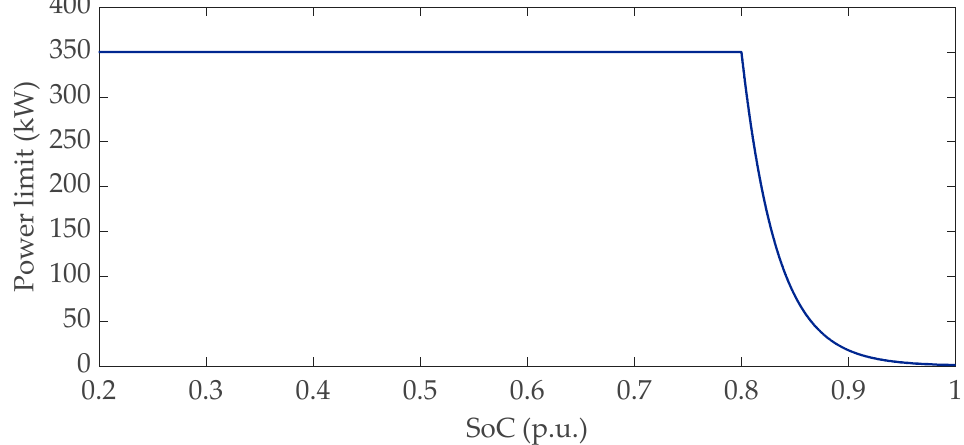
Figure 7. Profile of the limit of the charging power related to the SoC.